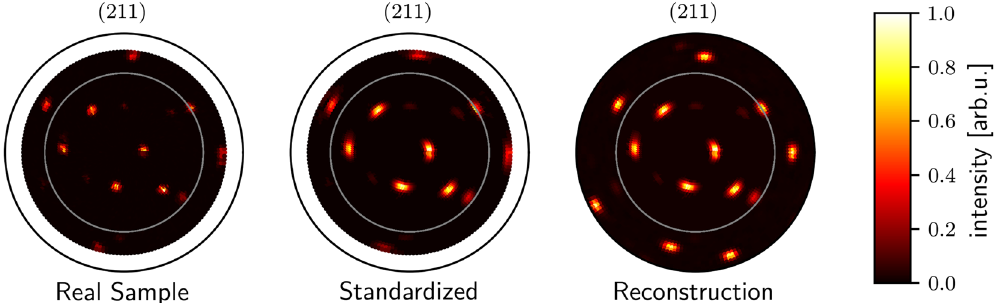
Figure 6. Reconstruction of a 211 lattice plane pole figure of a Fe–Mn–Al–Ni–Ti specimen. The label from the real pole plot was recorded up to ψ max = 76 ◦ . However, we input only the part of the real pole figure up to ψ max = 60 ◦ , so we can use the residual measurement as verification of our reconstruction. In the real sample plot, we plot the input sample inside of the gray circular boundary line and outside of the gray line we plot the rest of the real sample that was still recorded but not shown to the neural network. In standardized we also plot the real sample but after pole plot standardization. In reconstruction, we plot the standardized version of the real data within the gray boundary which is the input for the reconstruction network. Outside of the boundary line, we plot the complete recorded data in the input with ψ max = 60 ◦ . The reconstruction network can restore the position of all poles, even the poles with low intensity. All pole plots are min–max